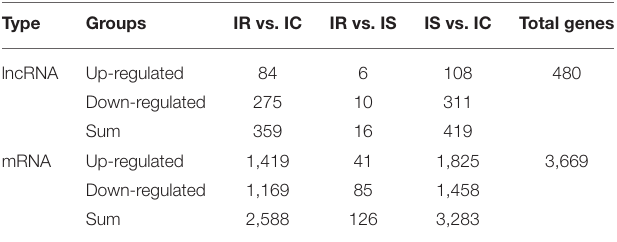
TABLE 1 | Number of differentially expressed lncRNAs and mRNAs in each comparison. Type Groups IR vs. IC IR vs. IS IS vs. IC